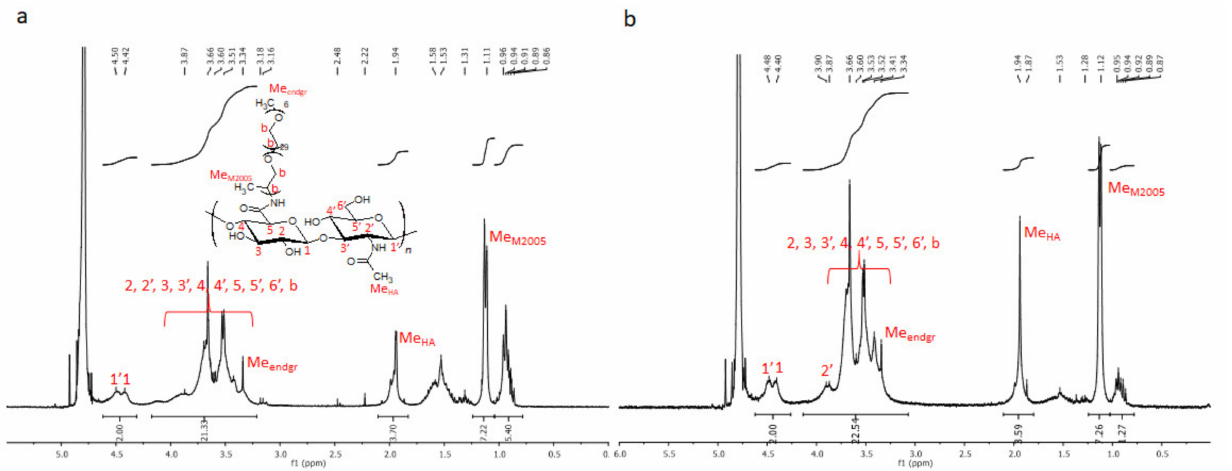
Figure 3. 1 H NMR spectrum of ( a ) HA 38 - g (T3P) -M2005-8.3% and ( b ) HA 140 - g (T3P) -M2005-8.3% in D 2